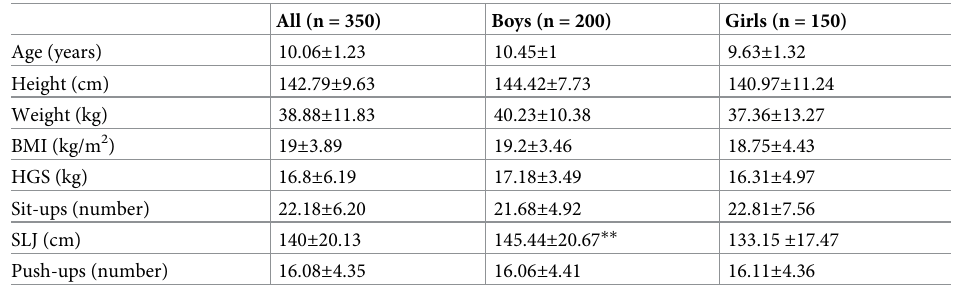
Table 1. Characteristics and genotypes contribution of the